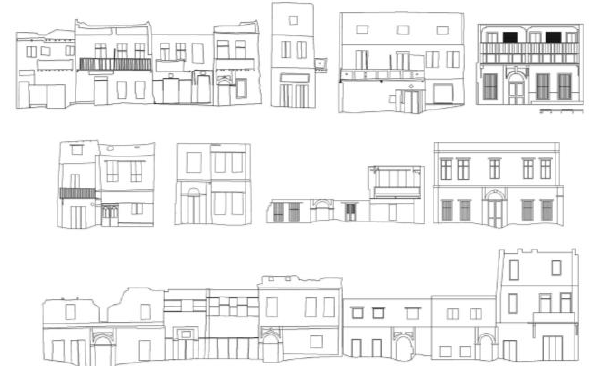
Figure 11. Architectural survey of a number of vernacular architecture houses in Lahun,